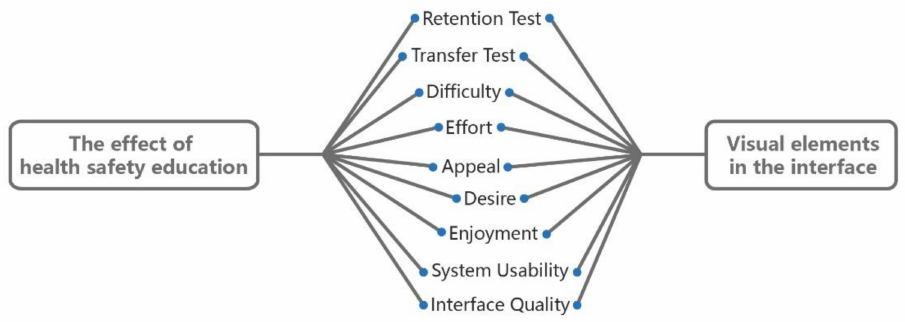
Figure 5. The evaluation framework associated with the educational effect in this